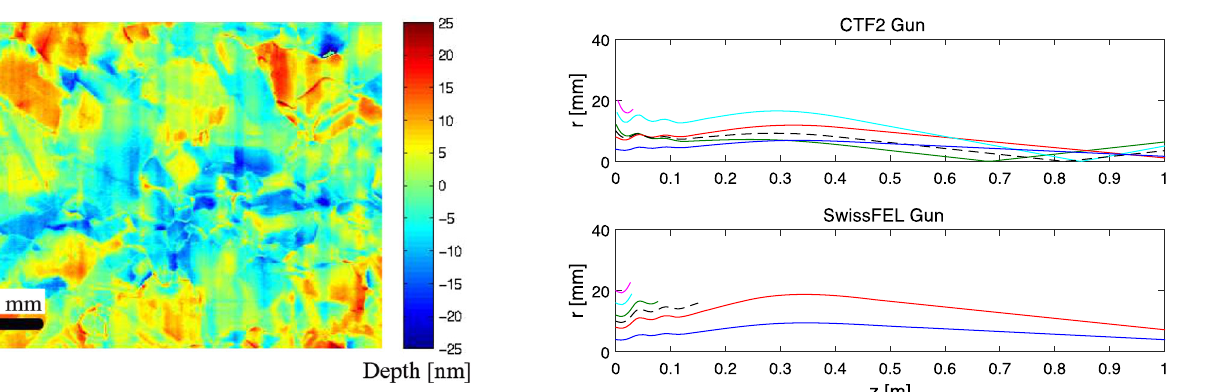
FIG. 8. Trajectories of particles emitted at distance r ¼ 4 , 8, 10, 12, 16, 20 mm from the center of the cathode. Each line corresponds to a different distance. The emission is at the operating phase of the gun corresponding to the center of the emission time of the nominal beam. The dashed line corresponds to a starting position of r ¼ 10 mm, where the gap of the cathode plug lies. The top plot refers to the CTF2 and the bottom one to the PSI gun, respectively.